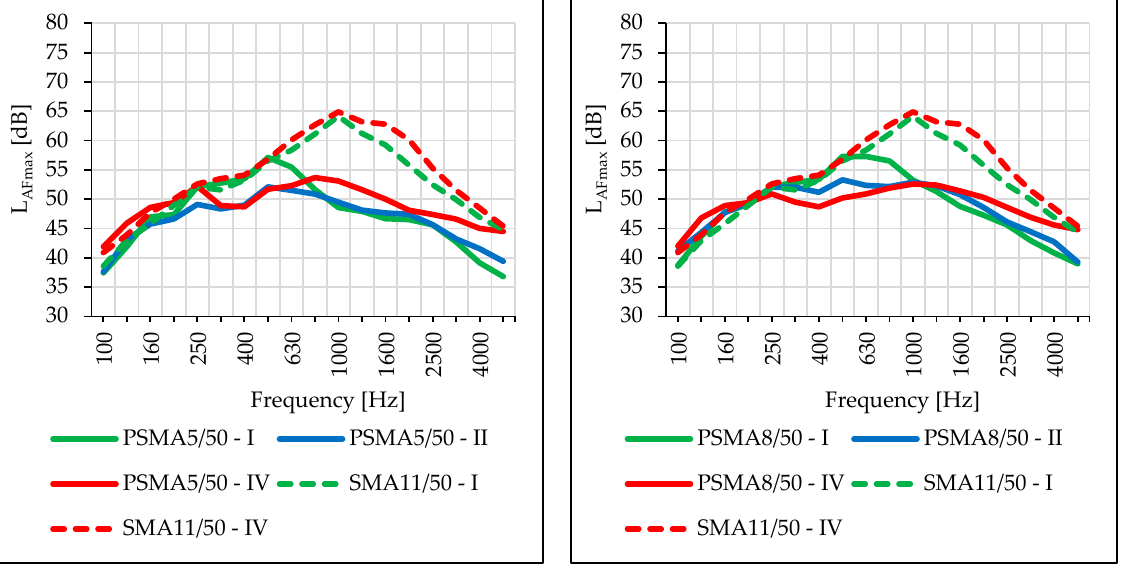
Figure 28. Comparison of sound spectra from a statistical passenger vehicle depending on the period of road use (PSMA5 and PSMA8).